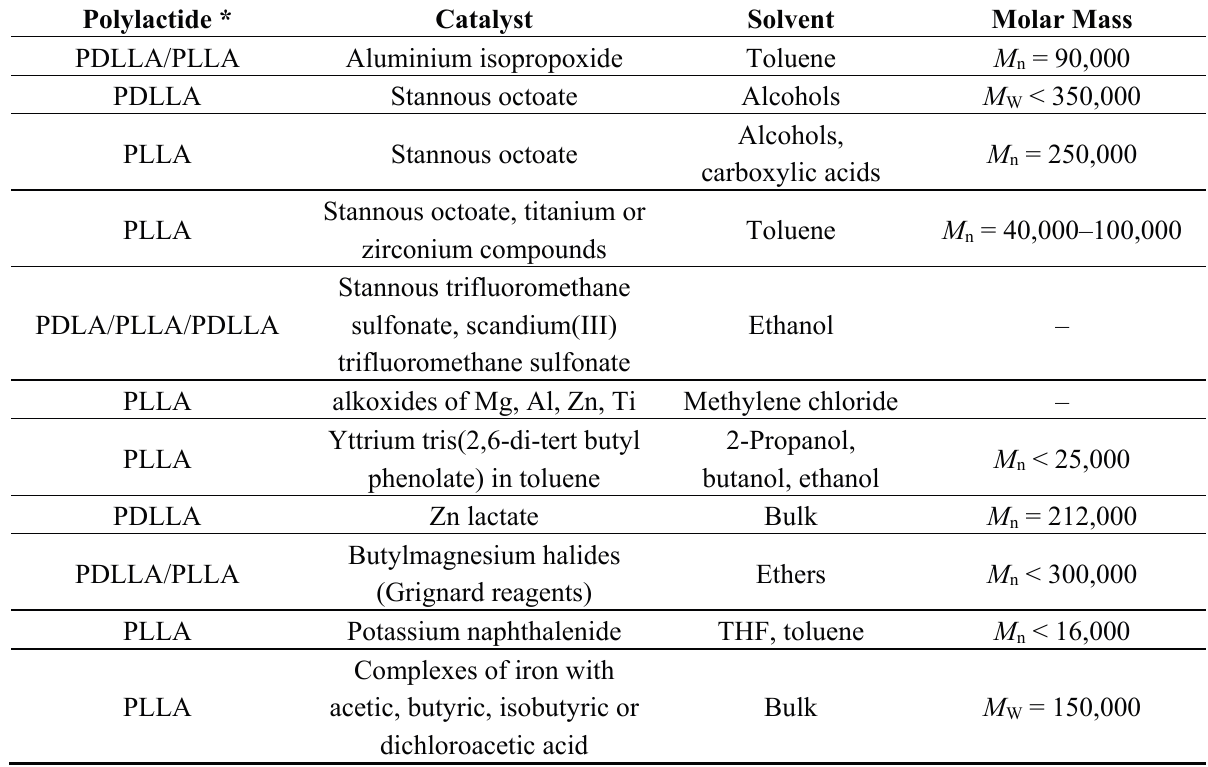
Table 1. The catalysts used for the preparation of PLA based on